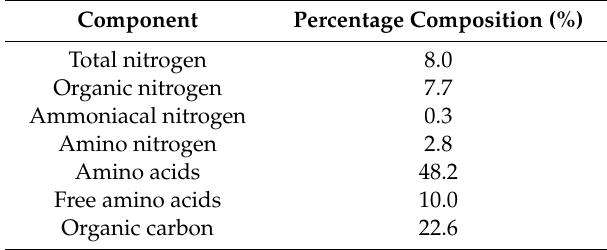
Table 8. Composition of A-PH tested (ASWELL ® , Mugavero fertilizers, Palermo, Italy).